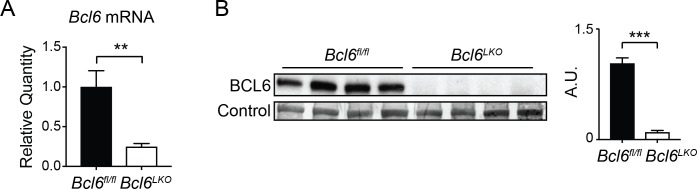
Bcl6LKO mice exhibit efficient protein and mRNA reductions of BCL6.(A) qPCR analysis of Bcl6 in Bcl6fl/fl and Bcl6LKO livers. N = 7 per group. (B) Western blots of BCL6 protein in Bcl6fl/fl and Bcl6LKO livers. Densitometric quantification is shown normalized to MemCode membrane staining (bottom). A two-tailed Student’s t-test assuming equal variance was used to compare mean expression between samples. Data are represented as mean ±SEM. ∗p<0.05, ∗∗p<0.01, ∗∗∗p<0.001.